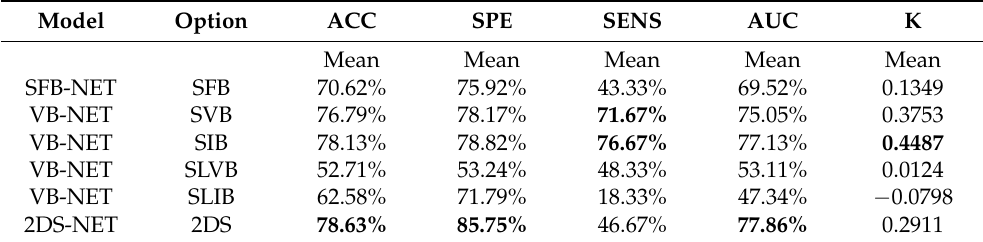
Table 5. Performance of the CNNs in LNS prediction (LN+ vs. LN − ). ACC (accuracy), SPE (specificity), SENS (sensibility), AUC (area under the curve), K (Cohen’s kappa coefficient), SFB (single fixed-size box), SVB (single variable-size box), SIB (single isotropic-size box), SLVB (single lesion variable-size box), SLIB (single lesion isotropic-size box), 2DS (two-dimensional slice), and NET (network). The best test performances are evident in bold.